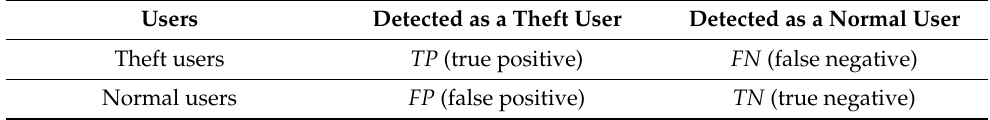
Table 3. Confusion Matrix in the Detection of Electricity Theft.